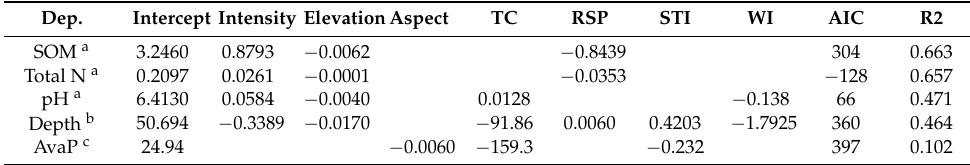
Table 3. The results of selected variables and general linear model regression (GLM).